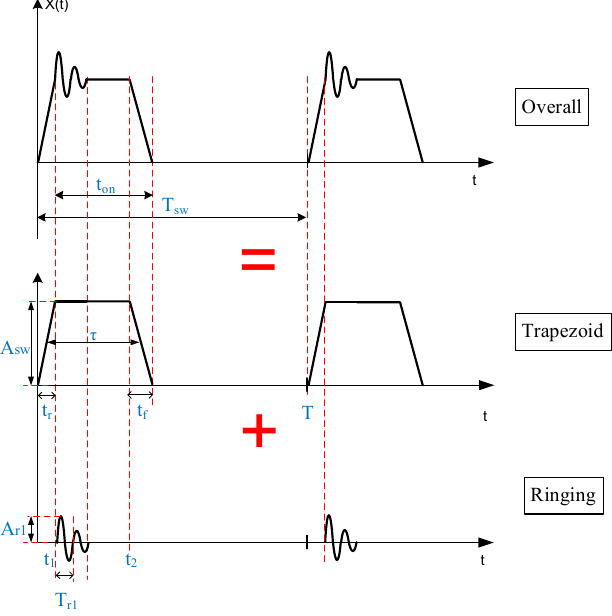
Figure 4. Decomposition diagram of the switch voltage